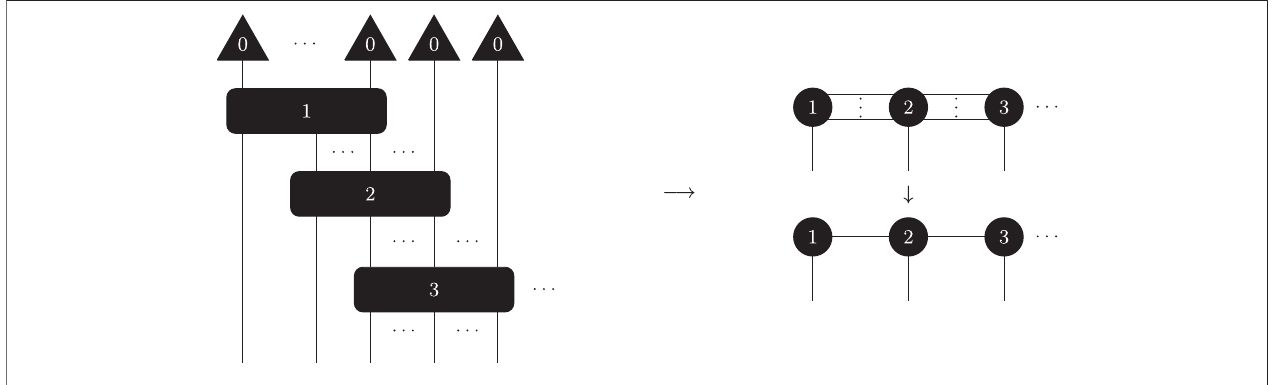
FIGURE 1 | Example of a tensor network as a quantum circuit: (left) quantum circuit realization of a matrix product state with open boundary conditions; (right) using standard graphical rewrite rules — or by manipulating equations — one readily recovers the familiar matrix product state depiction as a “ train of tensors. ”